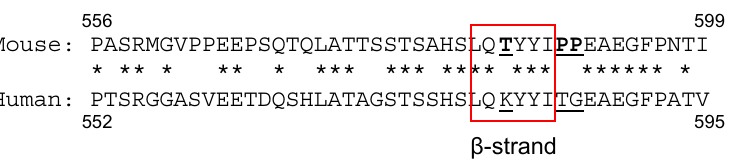
Figure 4. The amino acid sequence of mouse and human ER α F domains. The stars indicate identical amino acids between two species. The region of predicted β -strand is marked with red square. Mouse specific residues around the predicted β -strand are denoted as bold letters.